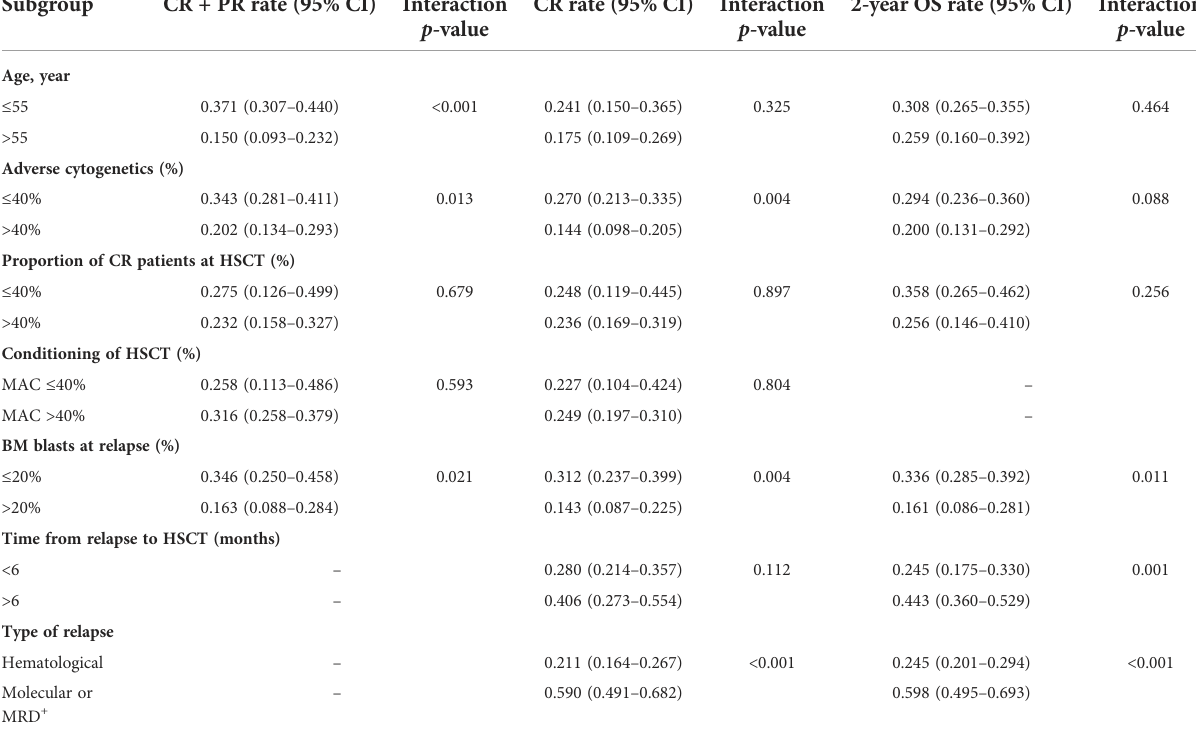
TABLE 4 Subgroup analysis of complete remission (CR) + partial remission, CR, and 2-year overall survival.